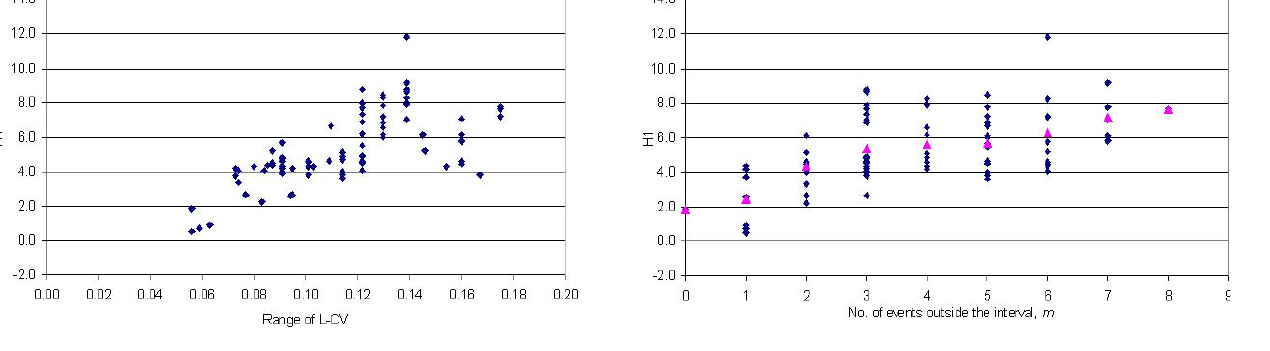
Fig. 4. H1 plotted versus range of L-CV. Each point represents a pooling group.